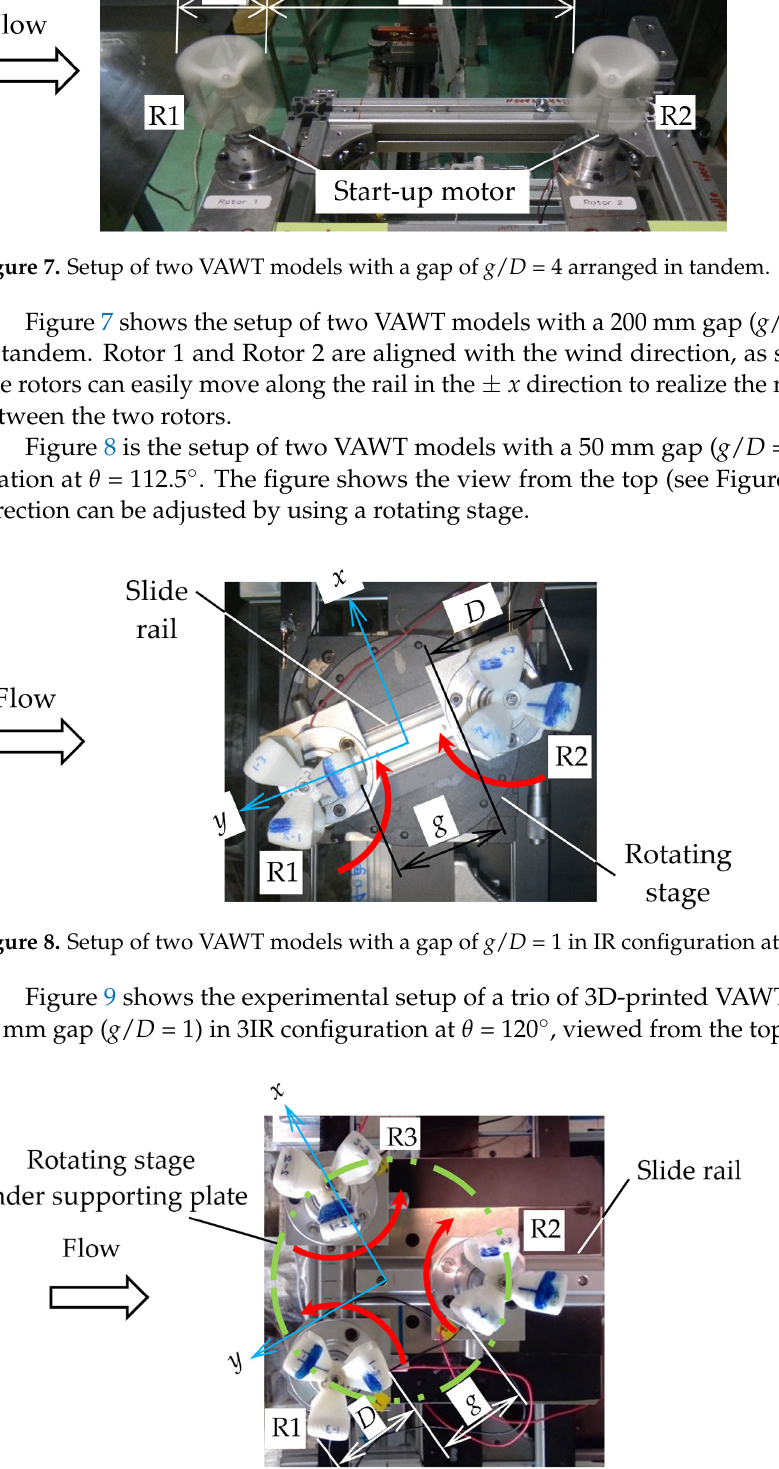
Figure 6. Free rotational speed of the single rotor along the streamwise direction at y = 0 mm.